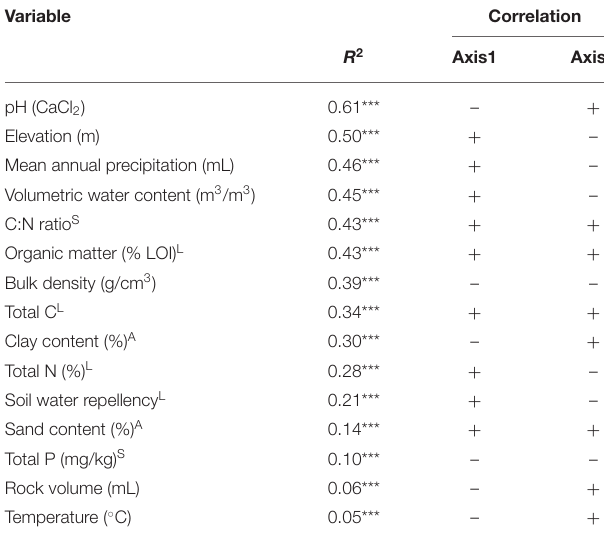
TABLE 4 | Summary of relationships amongst environmental factors and fungal communities based on 18S